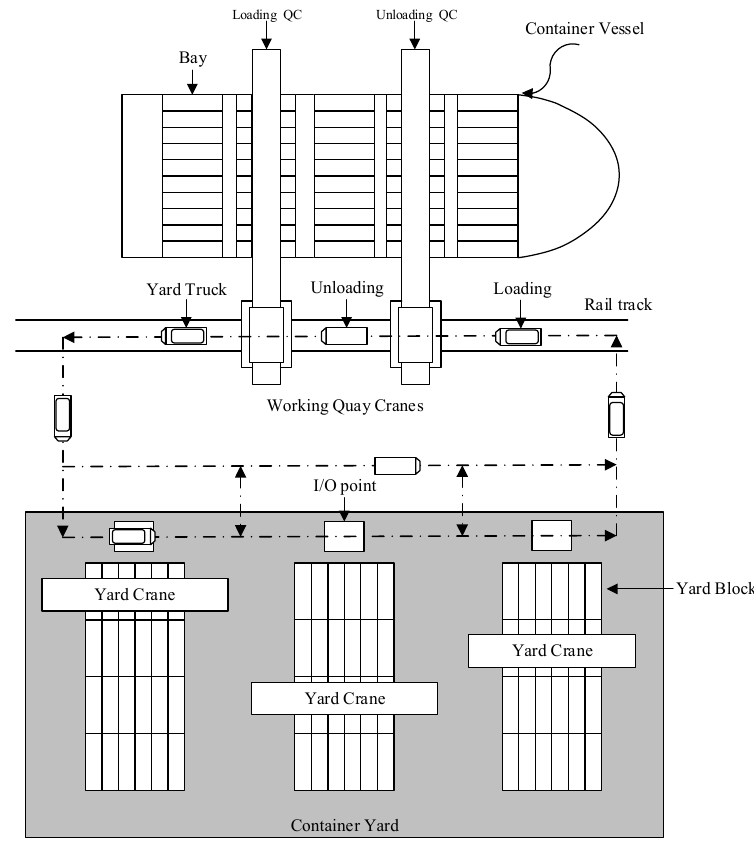
Figure 1. A double-cycling AGV scheduling mode.